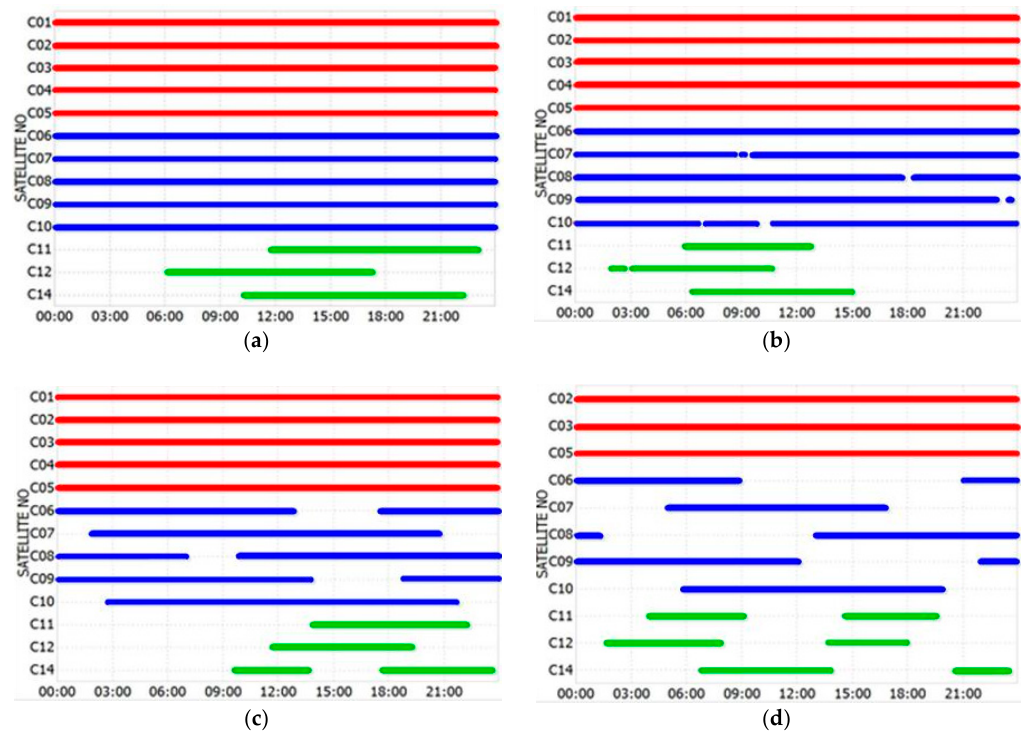
Figure 1. BDS satellite visibility at four sites in the northern hemisphere on Day 029/2015. SIN1 ( a ), DLTV ( b ), JFNG ( c ), and KZN2 ( d ). Red, blue, and green represent GEO, inclined geosynchronous satellite orbit (IGSO), and medium earth orbit (MEO) satellites, respectively.